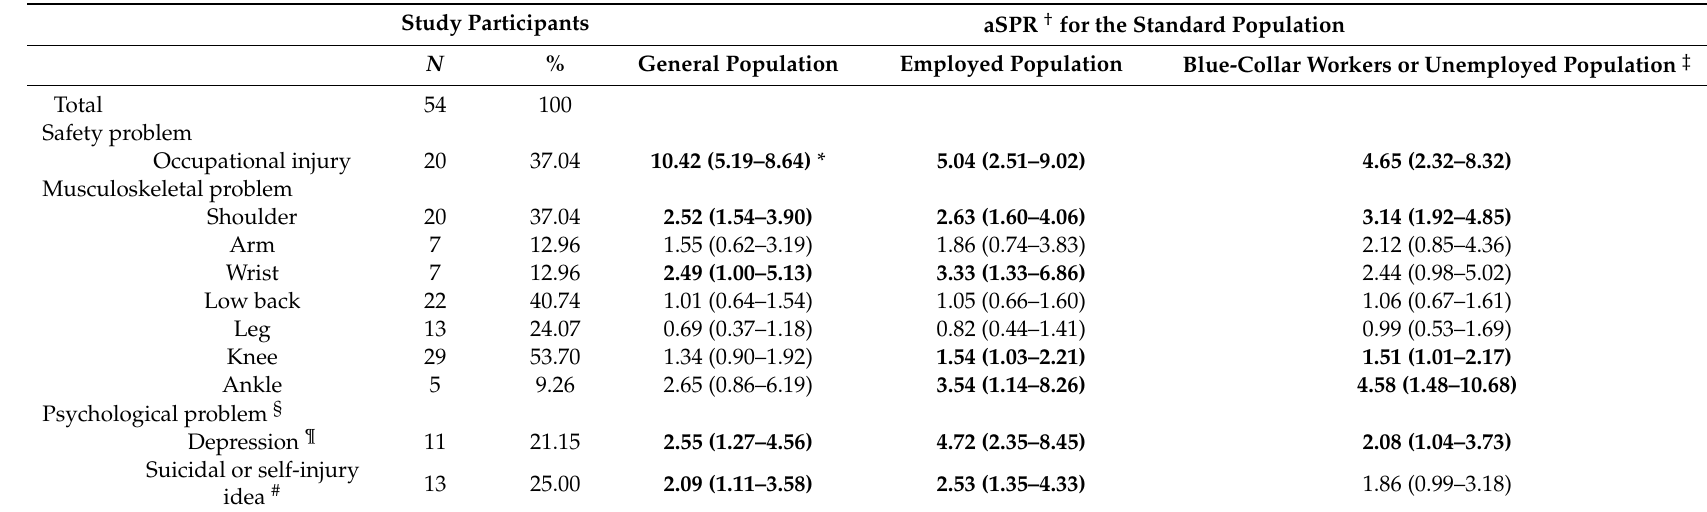
Table 3. Age-standardized prevalence rate (aSPR) for informal waste collectors’ safety, musculoskeletal, and psychological problems. Study Participants aSPR † for the Standard Population N % General Population Employed Population Blue-Collar Workers or Unemployed Population